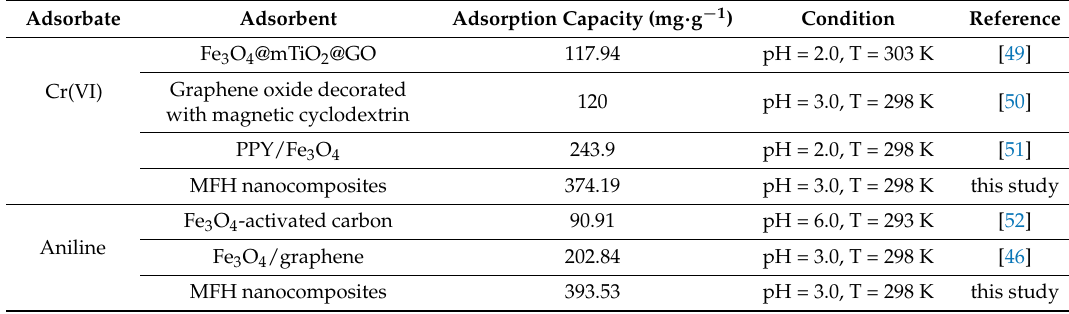
Table 4. Adsorption capacities of various magnetic adsorbents for Cr(VI) and aniline from